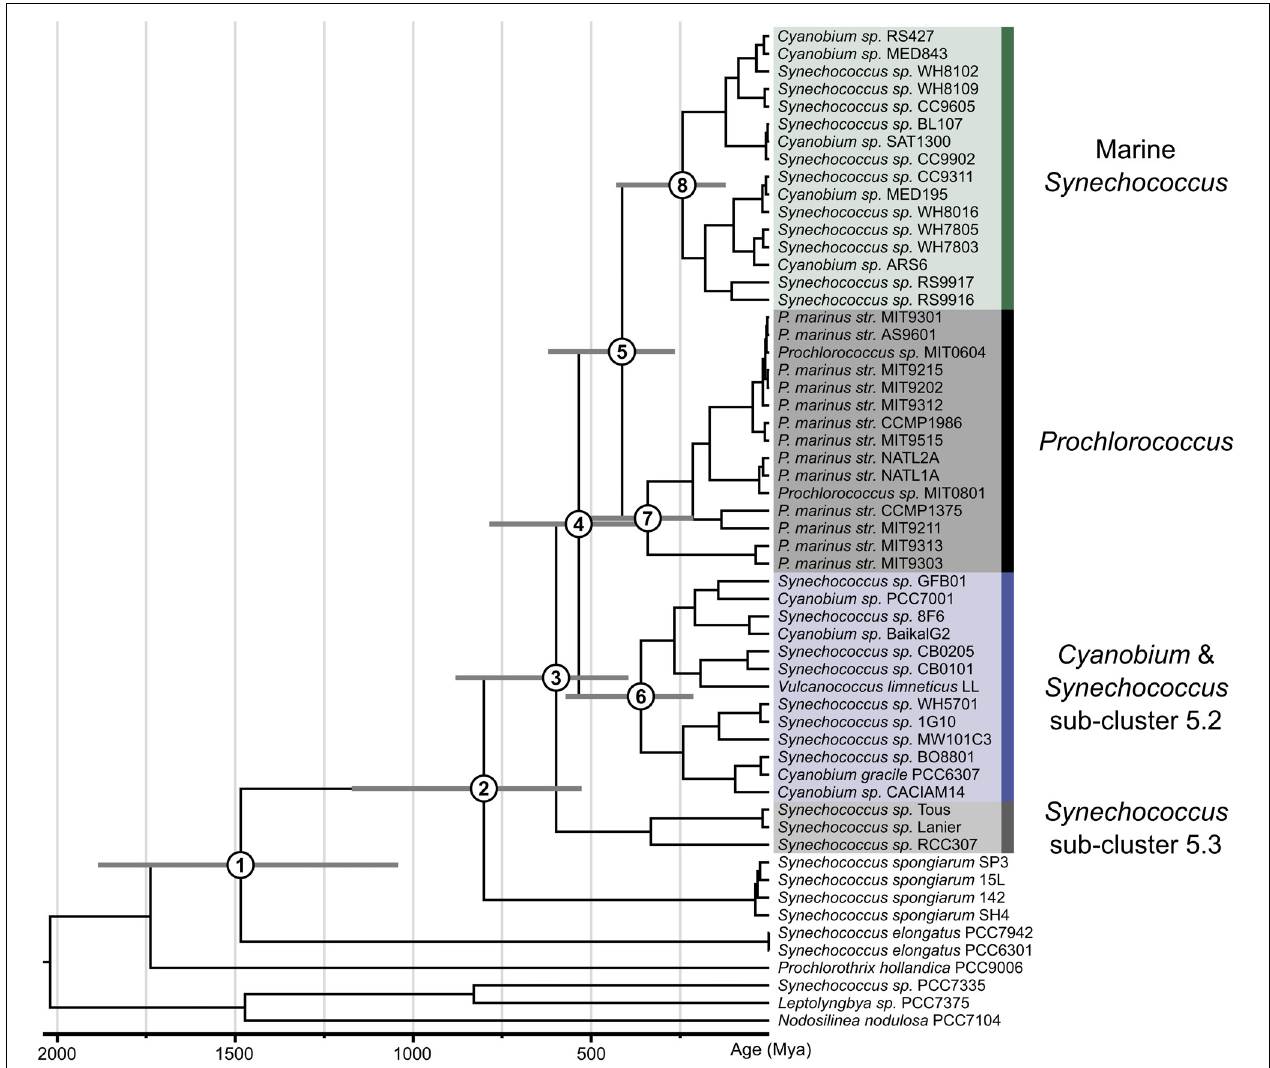
FIGURE 1 | Time calibrated phylogeny of picocyanobacteria as inferred from geological time. The phylogenetic tree shown was estimated based on 136 gene. Bayesian relaxed molecular clock analyses were carried out in Phylobayes 4.1 (Lartillot et al., 2009) implementing the UGAM (42) and the CAT-GTR-G substitution model. Age estimates for the numbered nodes (1–8) indicated are given in Table 1 , which includes the corresponding values for the posterior 95% confidence intervals.